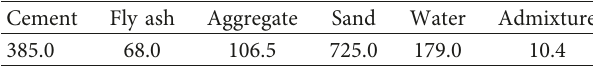
Table 1: Concrete mixing ratio (unit: kg). Cement Fly ash